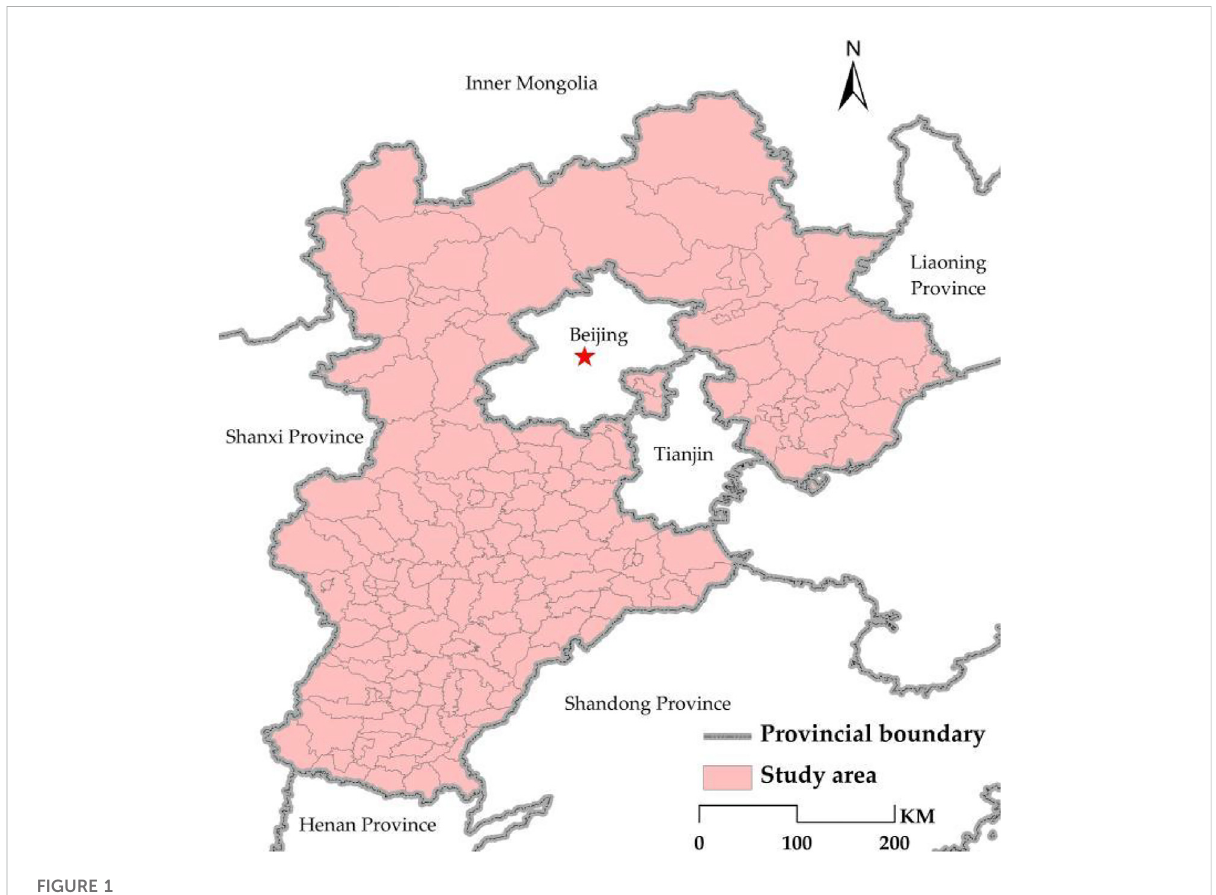
FIGURE 1 Spatial distribution map of the study